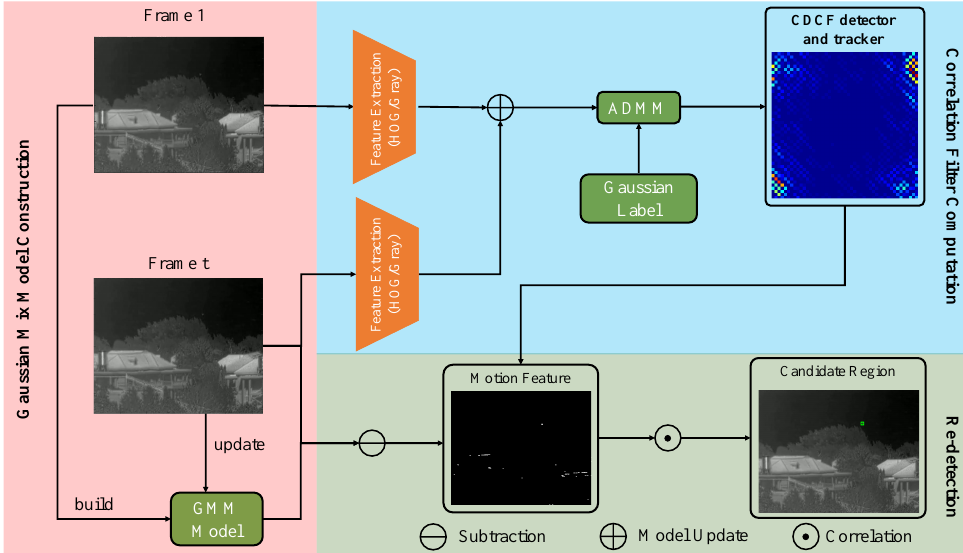
Figure 2. Pipeline of CDCF. We use the first frame of sequence to construct a Gaussian Mix Model (GMM), and update GMM model every frame. CDCF extracts hand-drafted feature to build a correlation filter, which can track target and redetect target when target